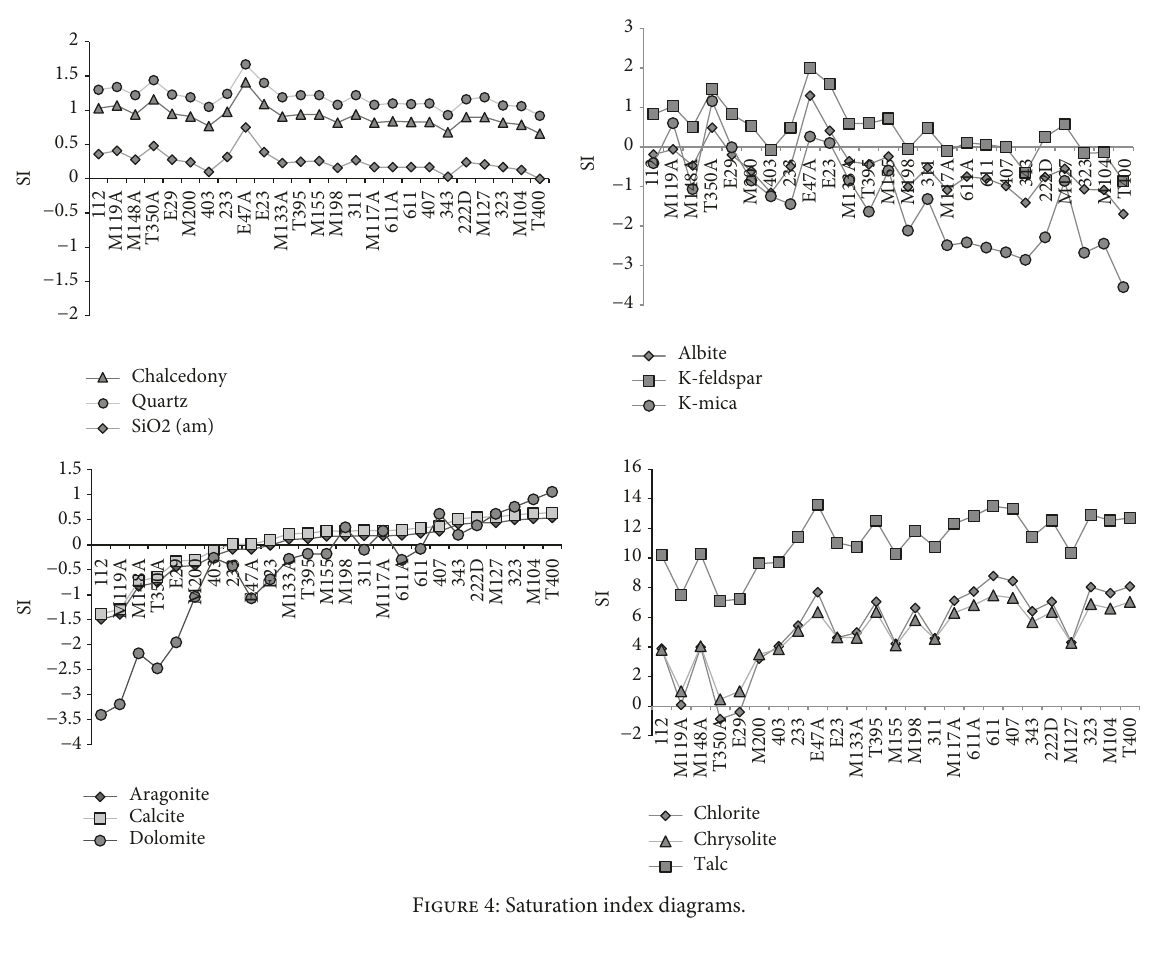
Figure 4: Saturation index diagrams.